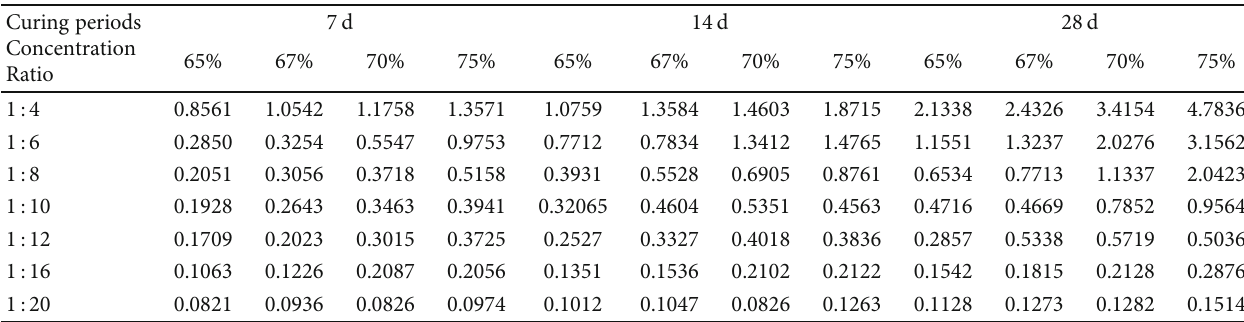
Table 3: The average test results of compressive strength of test blocks (unit: MPa).